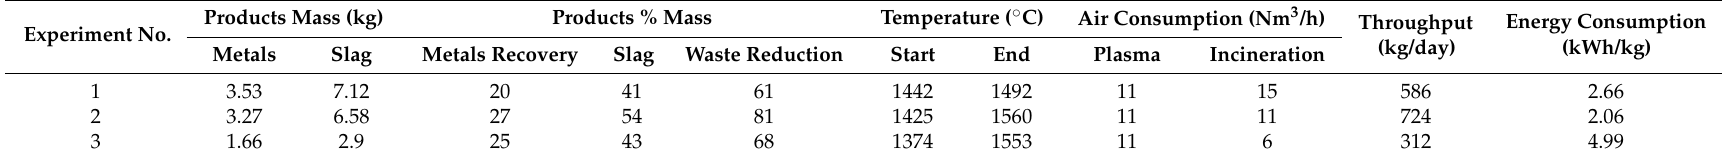
Table 4. Summarized results of processing of printed circuit boards in plasmatron plasma reactor. Experiment